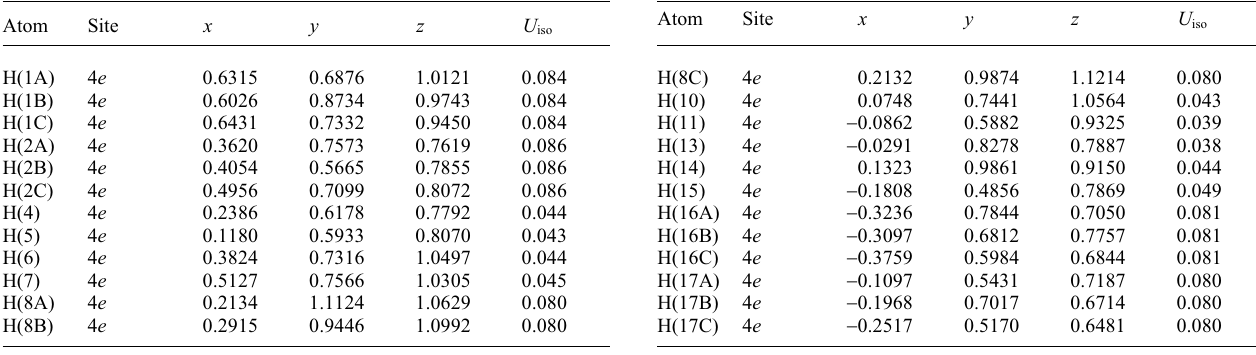
Table 2. Atomic coordinates and displacement parameters (in Å 2 ) . Table 2.